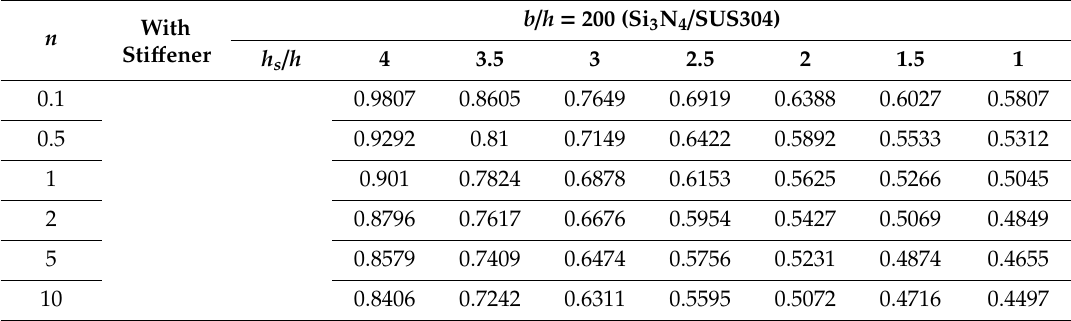
Table 9. Buckling coe ffi cient of FGM plate with and without a central sti ff ener (Si 3 N 4 / SUS304, b / h = 200).